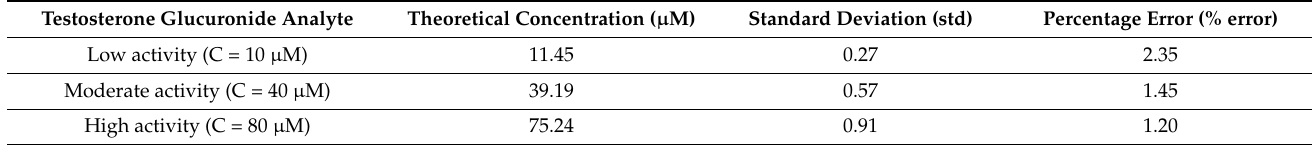
Table 8. Testosterone glucuronide intra-assay precision